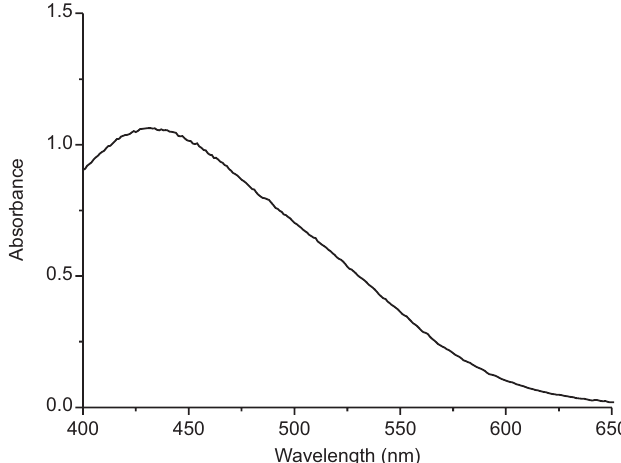
FIGURE 3 - Absorption spectrum of nitroso derivative of MTD in alkaline